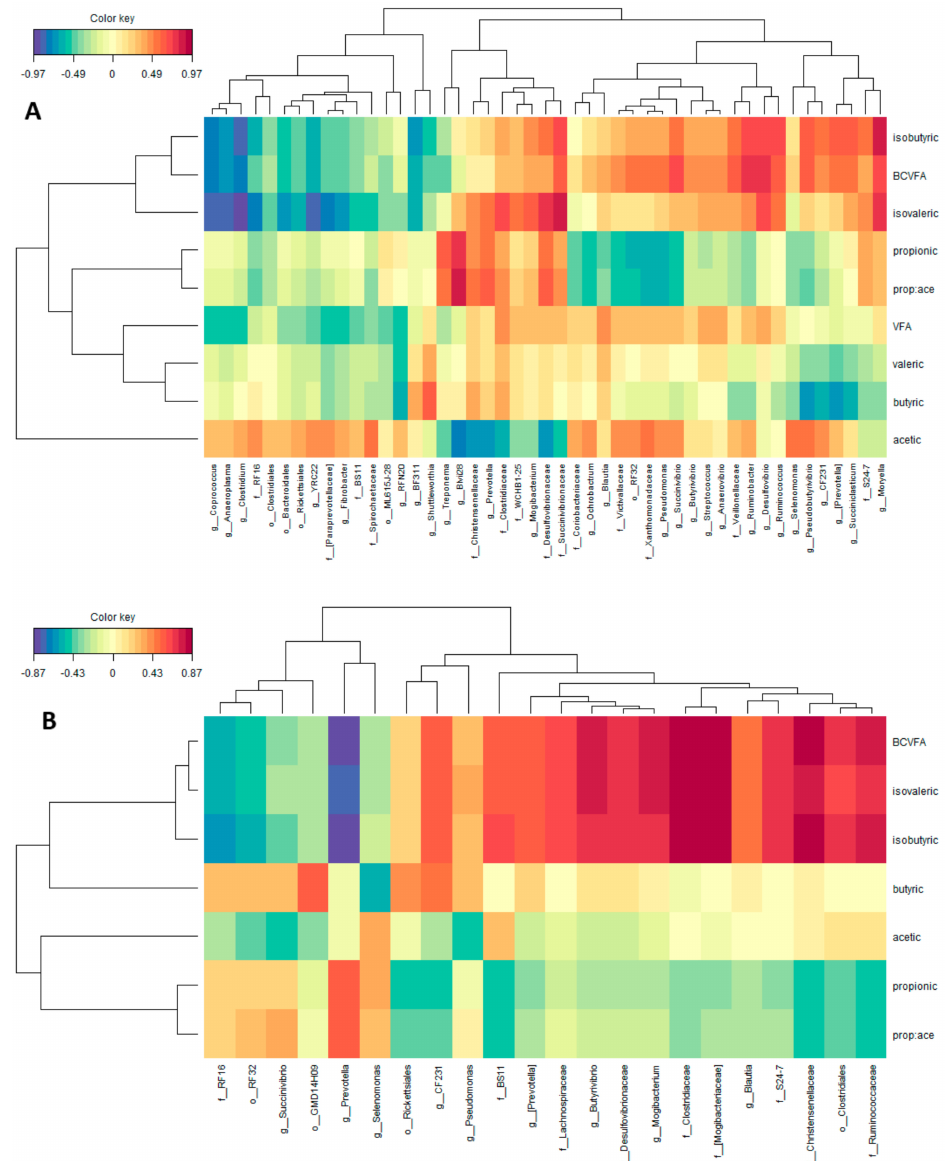
Figure 6. Relationships between clusters of bacterial genus and rumen VFA proportions in the Control group ( A ; n = 8) and in the groups fed SCG at di ff erent doses ( B ; n = 27). This clustered image map was based on the regularized canonical correlations between relative bacterial abundances and relative concentrations of rumen volatile fatty acids. Significant correlations are coloured following the key